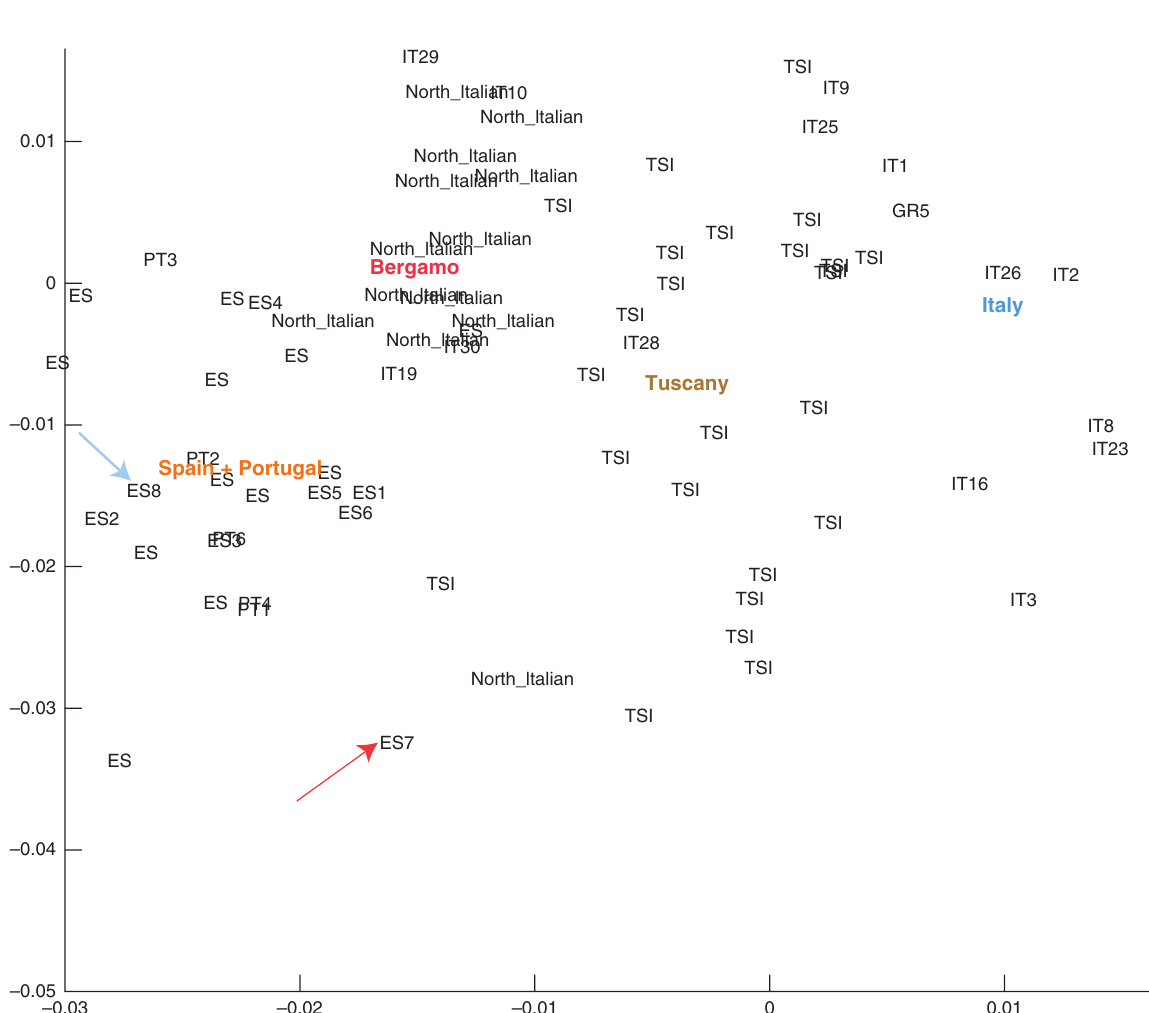
Figure 2. Admixture analysis of individuals from Southern Europe from the Eurogenes Genetic Ancestry Project. Mother (ES7) is denoted by a red arrow and Father (ES8) by a blue arrow. Mother and Father are the only family individuals included here as they have the most divergent genotypes within the family.